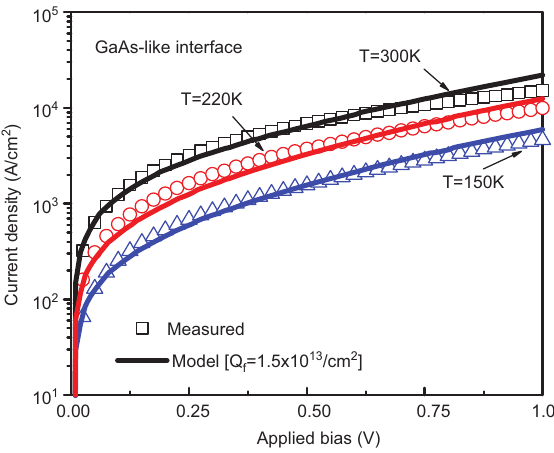
(V)Measured Model [Q f =1.5x10 13 /cm 2 Figure 27 Measured and simulated I-V characteristics of reverse- biased GaAs-like interface GaAs Sb /In Ga As p + -i-n + diode for 0.35 0.65 0.7 0.3 temperatures ranging from 150 K to 300 K. The direct BTBT model is in good agreement with measured data at different temperature ranges. The small temperature dependence and the high leakage current confirm that the tunneling process is the dominating OFF-state transport mechanism in this structure. Reprinted charge density caused by Tamm states and point defects related to the high defect density at the GaAs-like interface leads to interband tunneling which dominates the OFF- state transport of the GaAs-like interface TFET structure. By contrast, a lower positive fixed change density, = 10 12 cm -2 , due to lower defect density at the source/ Q f Sb /In Ga As p + -i-n + 0.35 0.65 0.7 0.3 channel interface was incorporated in the simulation of OFF-state performance of the InAs-like interface device. The simulated energy band diagram of the InAs-like inter- face TFET structure with a fixed interface charge density of = 10 12 cm -2 is shown in Figure 28B [11]. One can see from Q f Figure 28B that the type-II staggered band alignment was well maintained in the InAs-like interface TFET structure, which leads to lower leakage current at OFF-state. The field-enhanced SRH G-R mechanism [59] is also observed in Figure 28B, where the carriers in the p + source region firstly tunnel into mid-gap states and a subsequent thermal emis- sion process inject them into the conduction band of the channel. To gain further insight into the band alignment of these TFET structures as a function of fixed positive charge density within the source/channel interface region, simula- tion was performed to generate band diagrams at different Q values. As shown in Figure 29 [11], E decreases with f beff increasing value of Q . One can see from Figure 28B that f by varying the Q value, the band line-up can be converted f from staggered to broken gap. Although a broken line-up yields the best ON-state performance, it can also increase